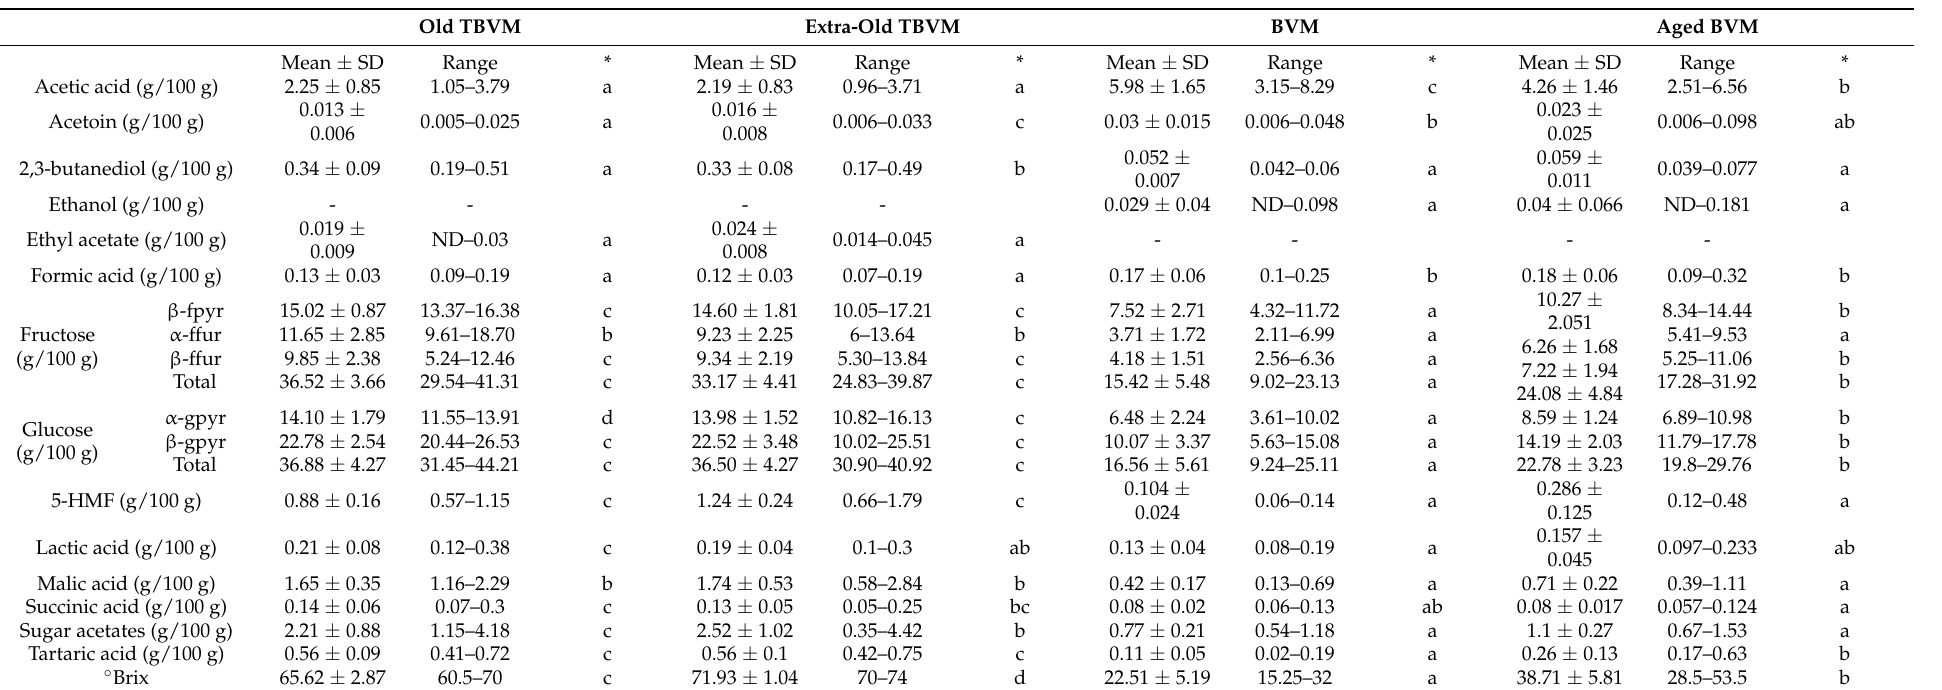
Table 2. Quantitative results of target compounds in old and extra-old TBVM and BVM and aged BVM. Results were expressed as mean, standard deviation, and interval